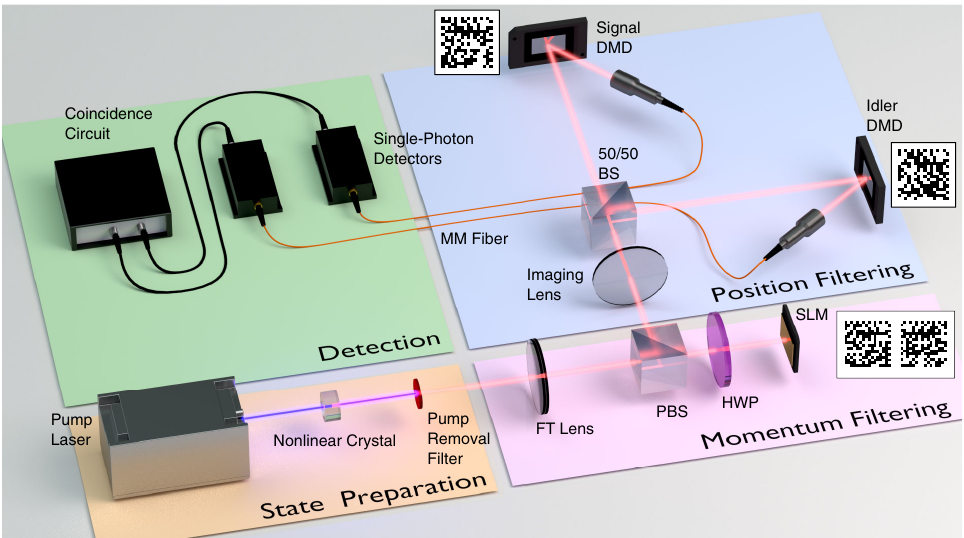
FIG. 2. Experimental setup. A two-photon, EPR-like state is generated by pumping a nonlinear crystal for type-1 SPDC. Random, binary patterns placed on a SLM in a Fourier plane of the crystal and on DMDs in an image plane of the crystal implement a sequence of random, partially projecting measurements. Example patterns are shown next to the SLM and DMDs; note the separate patterns for signal and idler photons on the SLM. Coincident detection events between single-photon detectors for signal and idler photons give information about both the joint-position and joint-momentum distributions of the two-photon